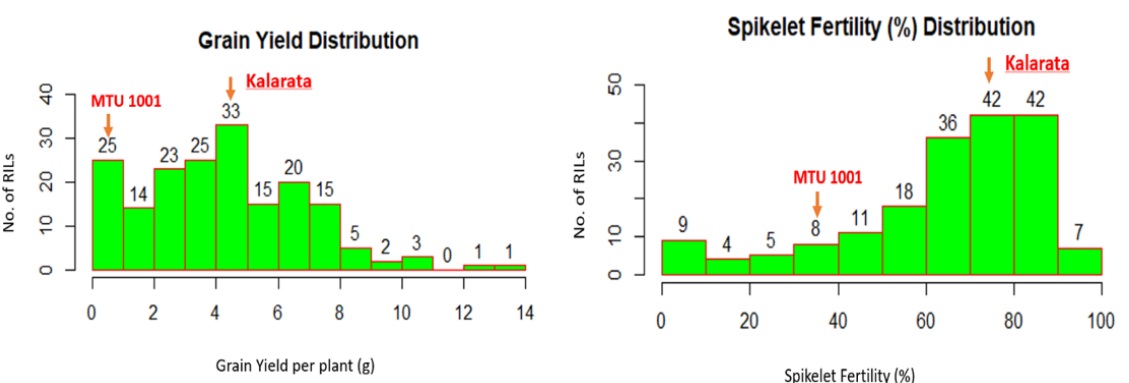
Figure 2. Histograms of distribution of RIL population for grain yield per plant (g) and spikelet fertility (%).